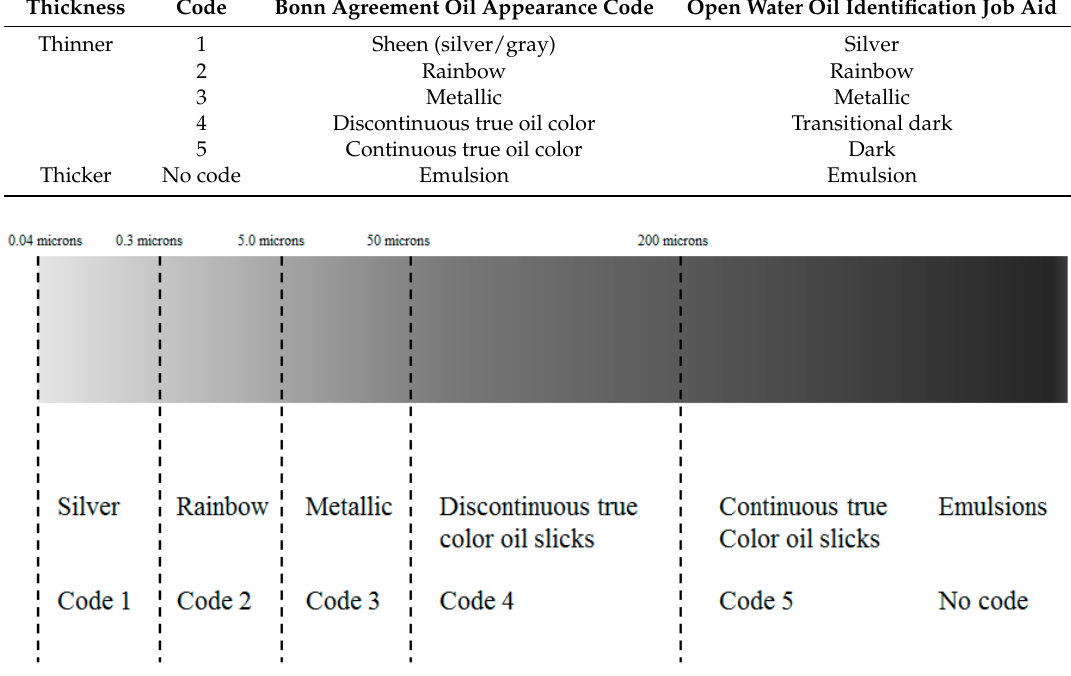
Figure 4. Oil slick thickness descriptions.